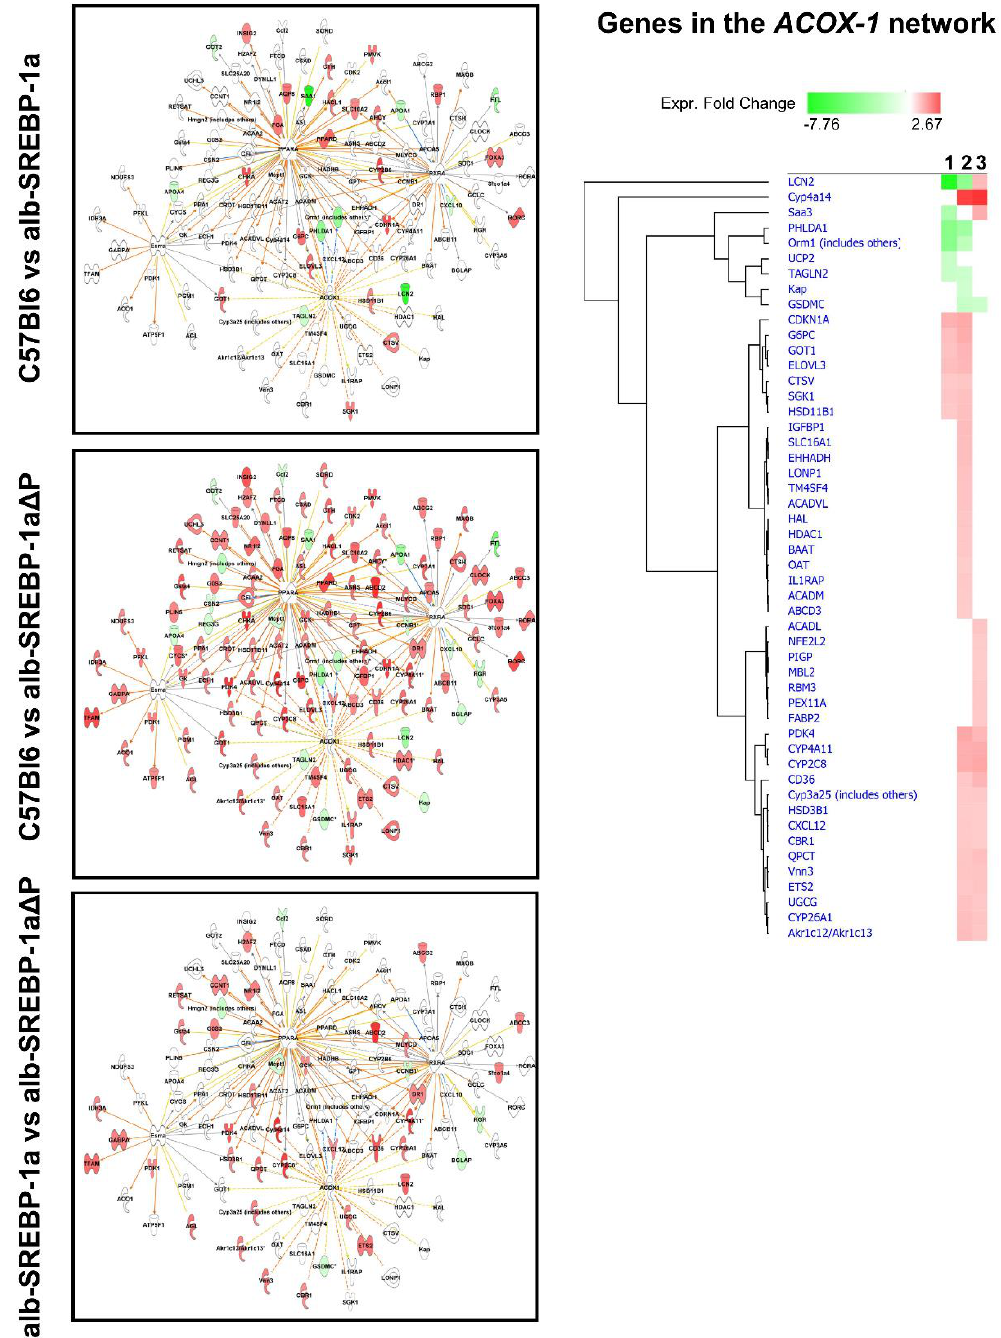
Figure 5. Overlap of the differential hepatic gene expression of the comparisons C57Bl6 vs. alb-SREBP-1a, C57Bl6 vs. alb-SREBP-1a∆P, and alb-SREBP-1a vs. alb-SREBP-1a∆P to interaction networks centered to PPARA or ACOX-1. Genes with differential gene expression (1.5-fold, p-value < 0.05) were used for IPA core analyses. Color code indicates knowledge-based interpretation (amber: predicted activation, blue: predicted inhibition, yellow: inconsistence with state of downstream molecule, black: effect not predicted) and different abundance (red: increase in condition 1, green: decrease in condition 1) based on measured expression. Different abundance of network genes is indicated in detail in the hierarchical cluster with 1: C57Bl6 vs. alb-SREBP-1a, 2: C57Bl6 vs. alb-SREBP-1a∆P, and 3: alb-SREBP-1a vs. alb-SREBP-1a∆P.